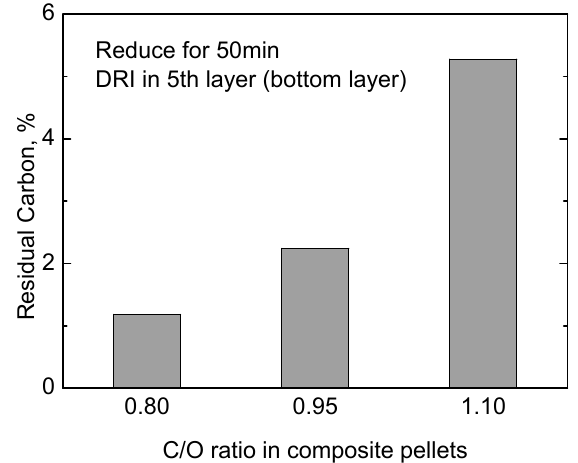
Figure 10. Residual carbon of the direct reduced iron (DRI) in the 5th layer (bottom layer).